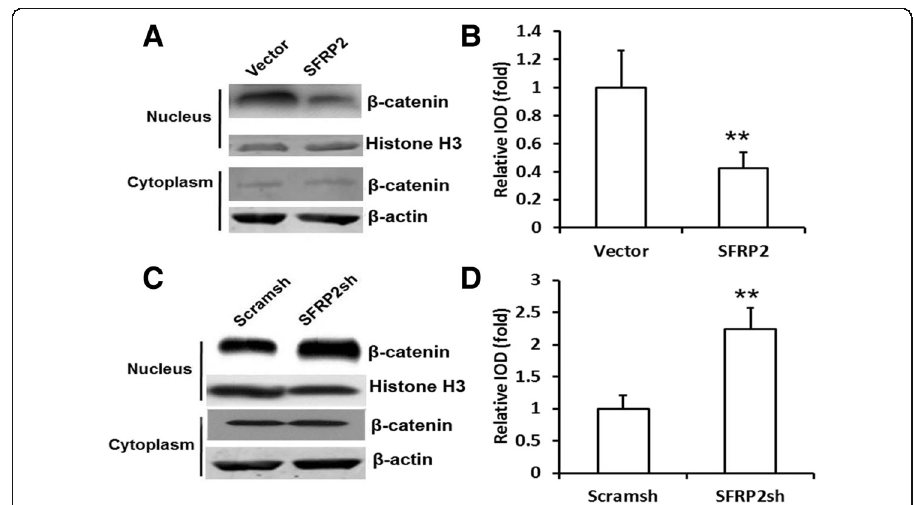
Fig. 2 SFRP2 inhibited β -catenin into the nuclei of SCAPs. a Western blot results showed that overexpression of SFRP2 decreased the level of nuclear β -catenin. b Quantitative analysis of nuclear β -catenin based on western blot results. c Western blot results showed that the depletion of SFRP2 upregulated the level of nuclear β - catenin. Beta-actin or histone H3 was used as an internal control. d Quantitative analysis of nuclear β -catenin based on western blot results. Student ’ s t test was performed to determine statistical significance. All error bars represent SD ( n = 3). ** p ≤